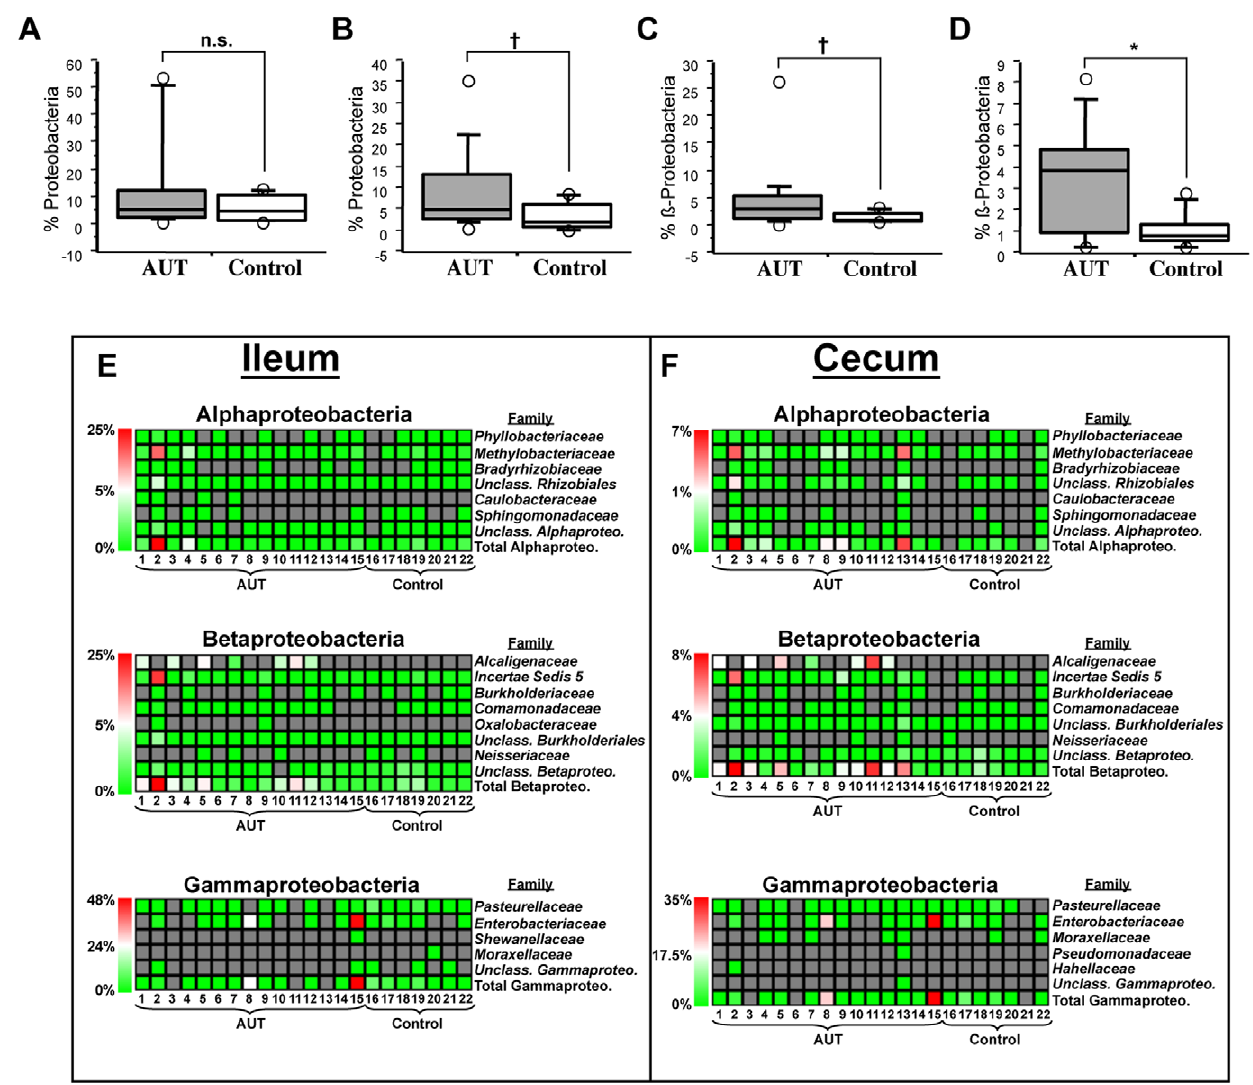
Figure 5. Abundance of Proteobacteria in AUT-GI and Control-GI children. ( A–B) Phyla-level abundance of Proteobacteria members in ileal ( A ; Mann-Whitney, p =0.549) and cecal ( B ; Mann-Whitney, p =0.072) biopsies obtained by pyrosequencing. ( C–D ) Class-level abundance of Betaproteobacteria members in ileal ( C ; Mann-Whitney, p =0.072) and cecal ( D ; Mann-Whitney, p =0.038) biopsies. ( E–F ) Family-level abundance distributions of bacteria within the classes Alpha-, Beta-, and Gammaproteobacteria in ileal ( E ) and cecal ( F ) biopsies: bottom row of each heatmap displays the cumulative levels of family members in each class of Proteobacteria by patient; gray cells indicate where no sequences were identified for a given taxa. *, p , 0.05; { , p , 0.1 (trend); n.s., not significant.